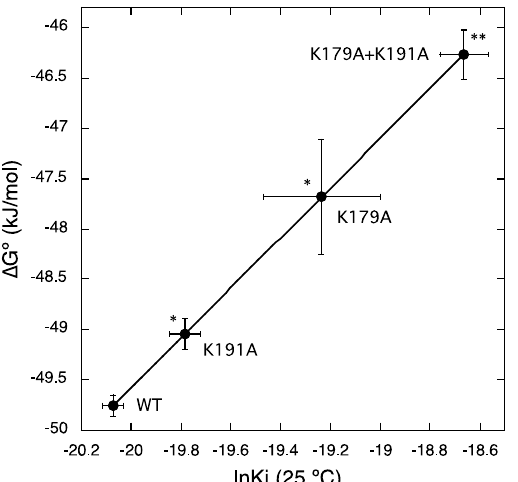
Figure 4. Changes in the values of ∆ G ◦ and ln K i of bilastine by mutations in Lys179 ECL2 and/or Lys191 5.39 . Scatter plots of values of ∆ G ◦ versus ln K i of bilastine for WT, K179A, K191A, and K179A + K191A are shown, in which ∆ G ◦ values were calculated according to the equation, ∆ G ◦ = RT ln K i, at a standard temperature of 25 ◦ C (298.15 K). Increases in values of ∆ G ◦ and ln K i represent reductions in the affinities for bilastine by mutations of Lys179 ECL2 and/or Lys191 5.39 . * p < 0.05, ** p < 0.01; compared to the values for WT.